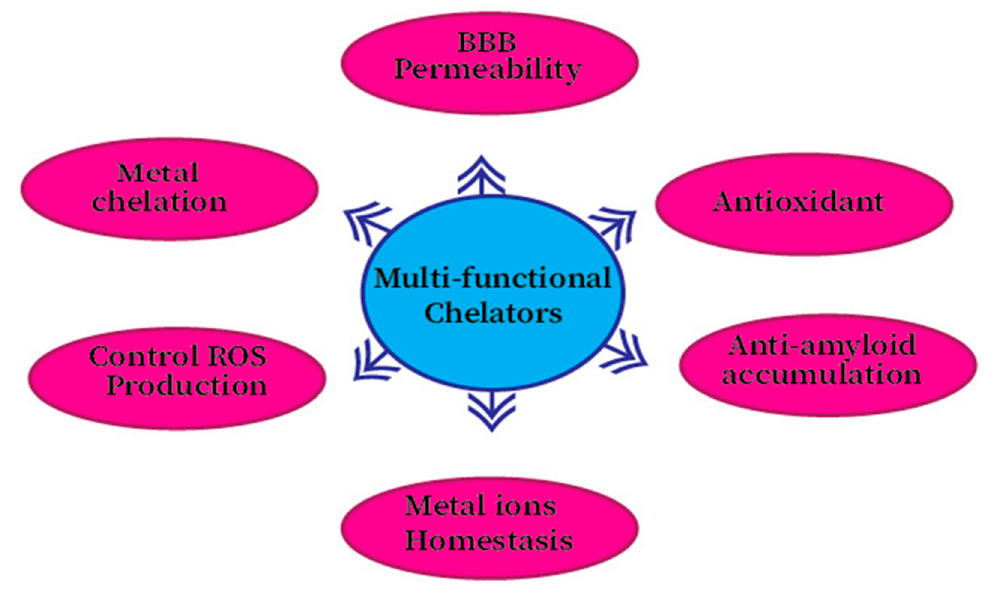
Figure 5. Multifunctional compounds (MFCs) target for Alzheimer’s Disease.